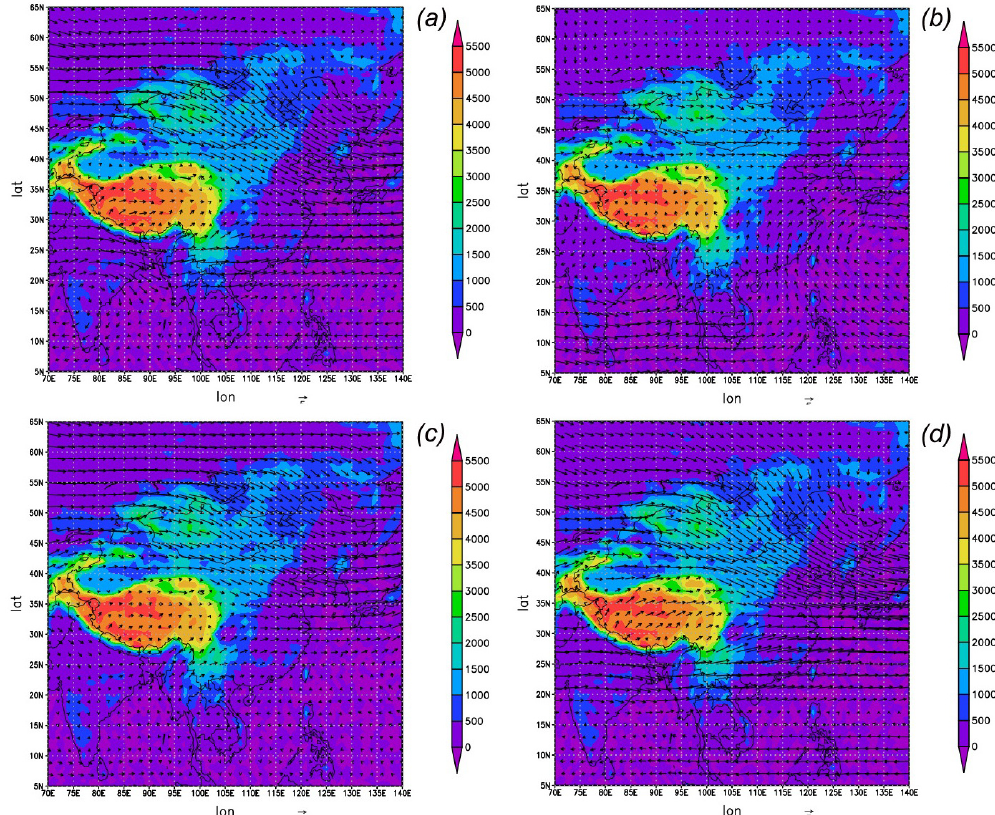
Figure 6. Wind field at 650hPa and geopotential height from 2011 to 2013: (a) spring, (b) summer, (c) fall and (d) winter. It was calculated using the Grid Analysis and Display System (GADS) and gridded meteorological data (1.0 ◦ × 1.0 ◦ ) from the NCEP FNL Operational Global Analysis